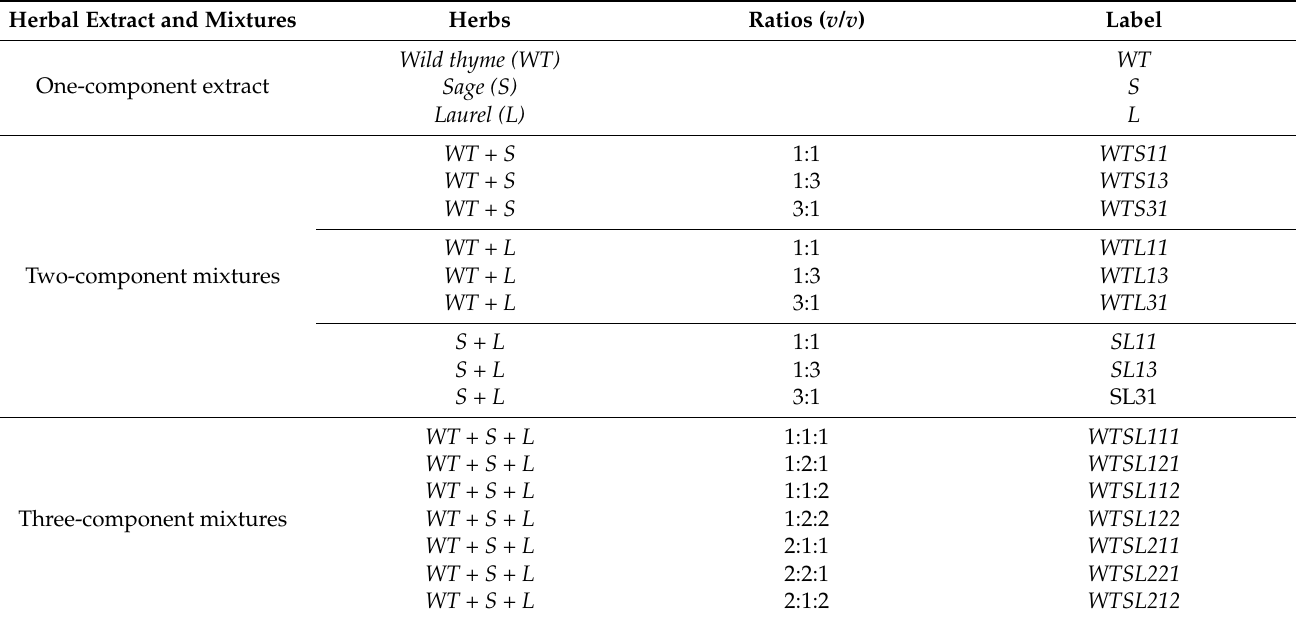
Table 1. Preparation of two- and three-component herbal extract mixtures. Herbal Extract and Mixtures Herbs Ratios ( v/v )